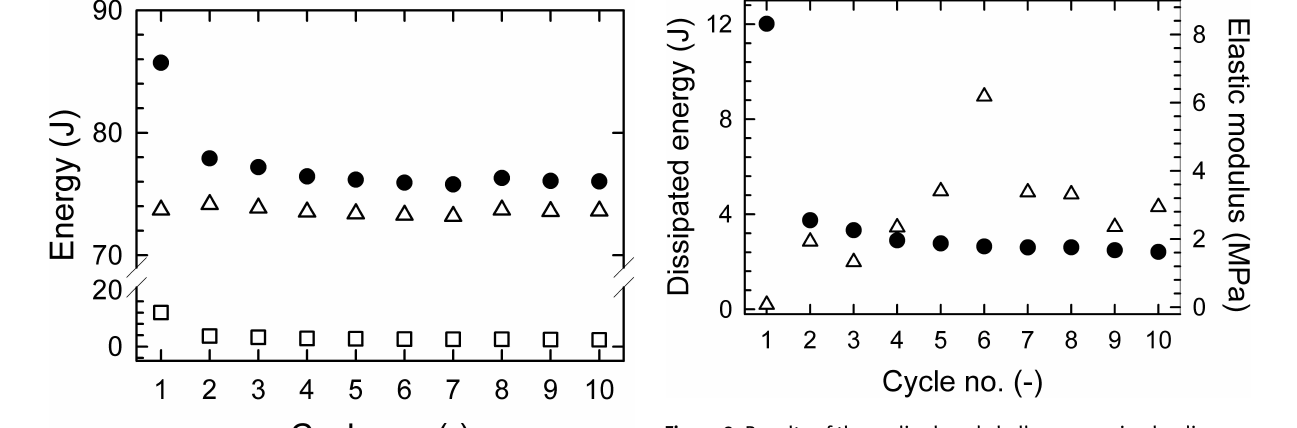
tion rate was found from 605 MPa for deformation rate of 0.2 mm/min to 643 MPa for 10 mm/min deformation rate.